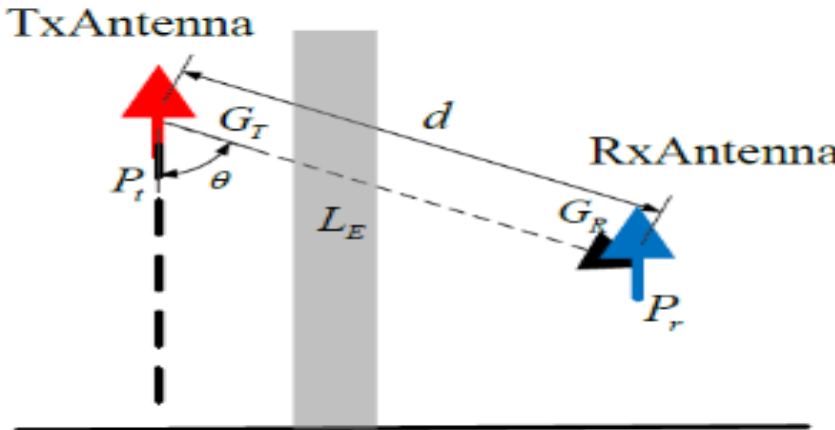
Figure 8. The receiving and the transmitting antennas. Table 2. The antenna setup features.